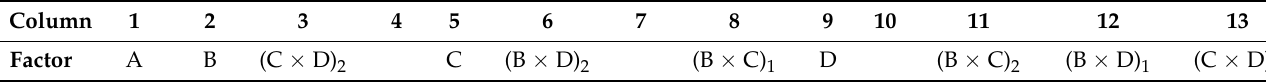
Table 2. Head of orthogonal array L 27 (3 13 ).